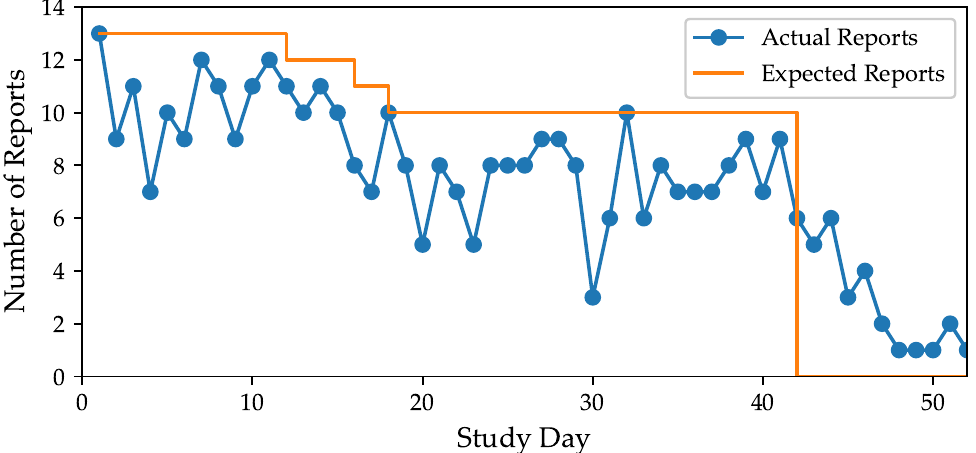
Figure 4. The number of participants that checked-in to the QuantifyMe App on each day of the study. The orange line displays expected number of reports for each